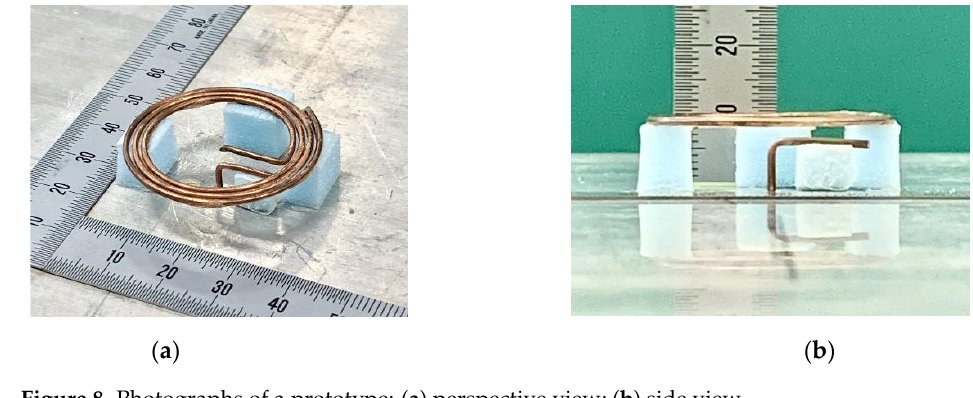
Figure 8. Photographs of a prototype: ( a ) perspective view; ( b ) side view. The solid lines in Figure 7b show the frequency responses of the axial ratio and gain.